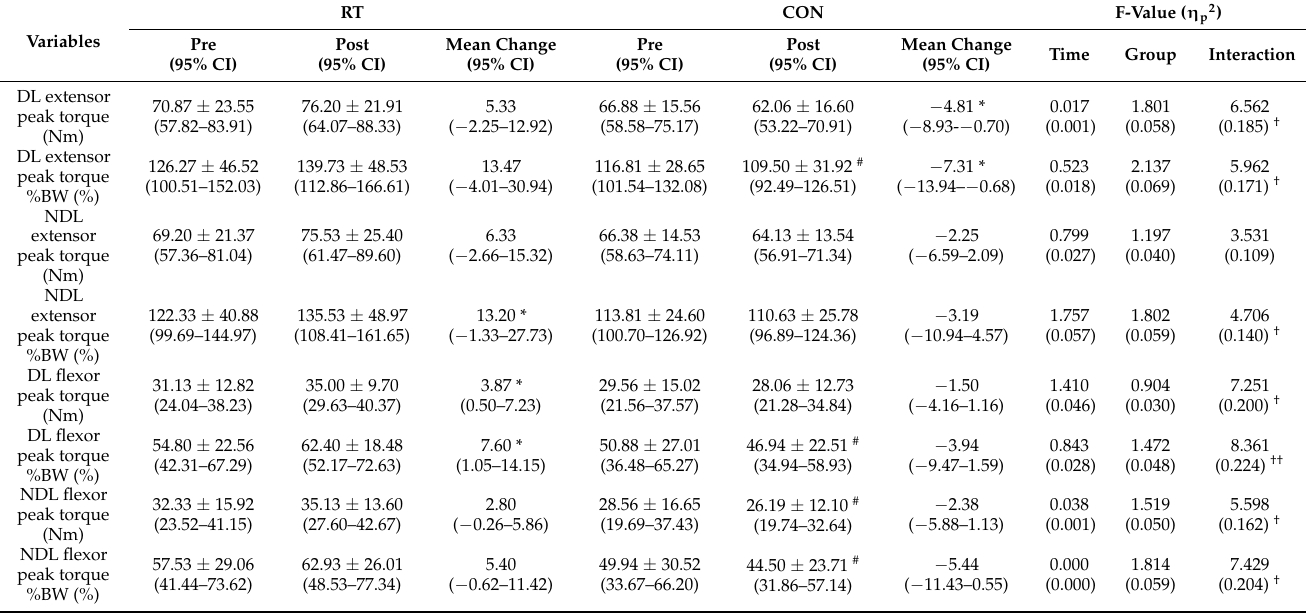
Table 5. Changes of isokinetic muscle strength at 60 ◦ /s between pre- and post-tests in obese older